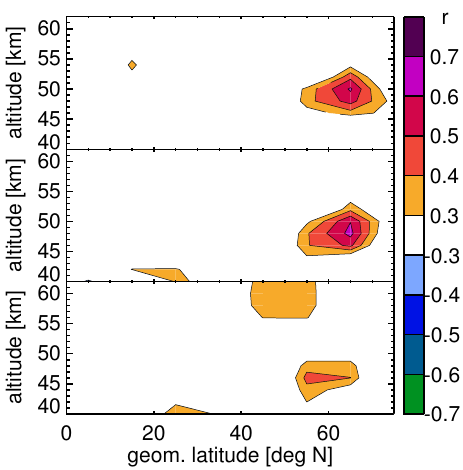
Fig. 3. Correlation coefficient r of the SEA with respect to ∆ Ap (epoch type 2) between ∆ Ap and ∆NO 2 , plotted over geomag- netic latitudes with 0/1/2 days delay (top/middle/bottom, respectively).